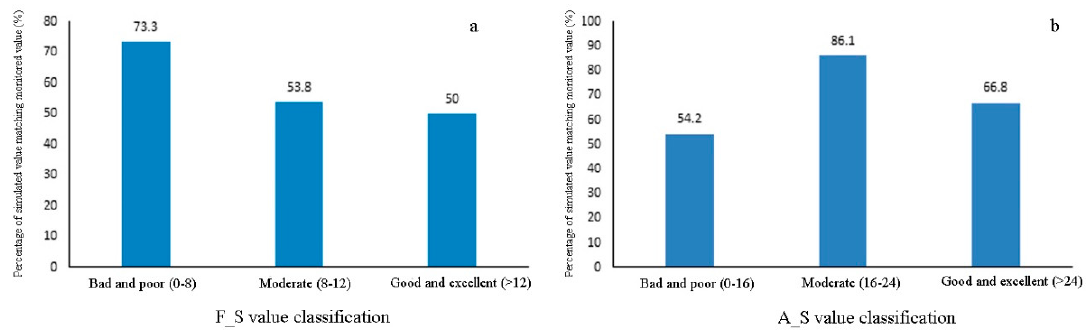
Figure 8. Verification of F_S ( a ) and A_S ( b ) simulation results.